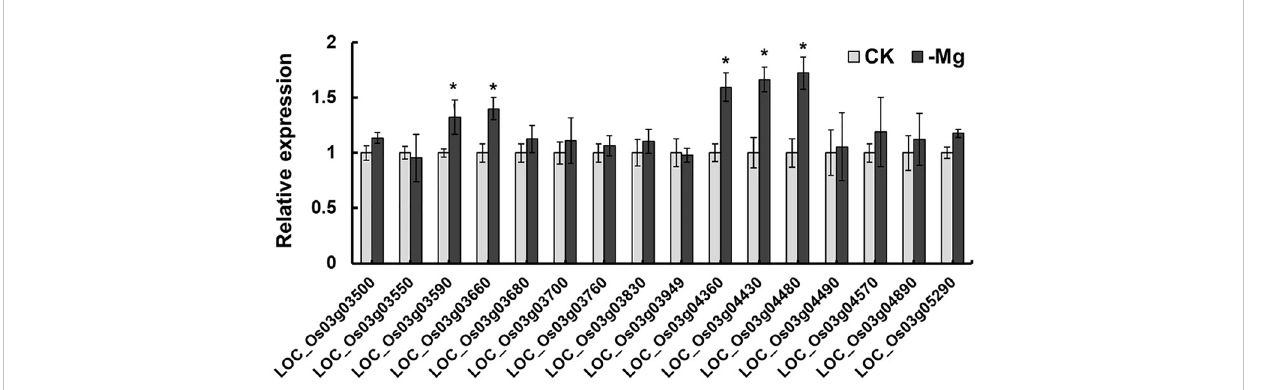
FIGURE 4 Relative expression of candidate genes for qSMg3 and qTrMg3 under different Mg 2+ concentrations. The rice cv. Nipponbare seedlings in the 1/4 strength IRRI solution for two weeks, and in IRRI solution with 1 mM Mg 2+ (CK) or without Mg 2+ (-Mg) for three weeks. RNA was extracted from rice roots. Values are mean ± SE (n = 3). * A signi fi cant difference at the 0.01